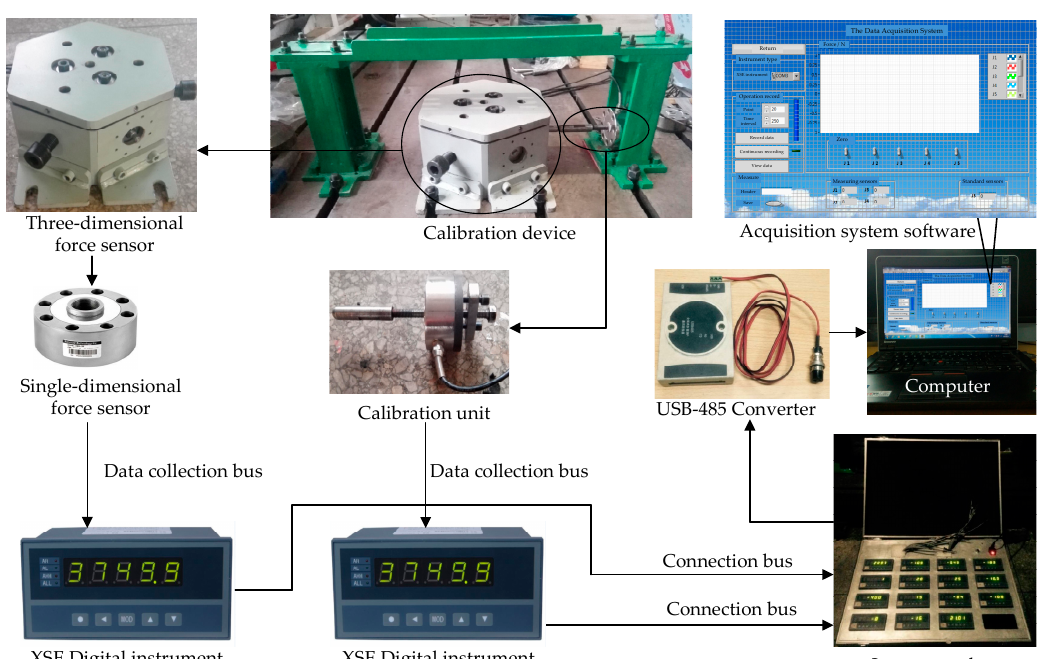
Figure 19. Flow diagram of the calibration system.